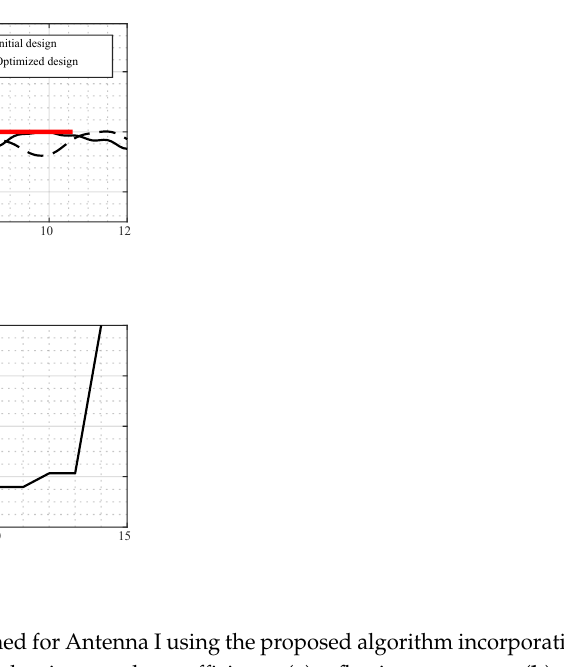
penalty function approach incorporating variable-fidelity model management.